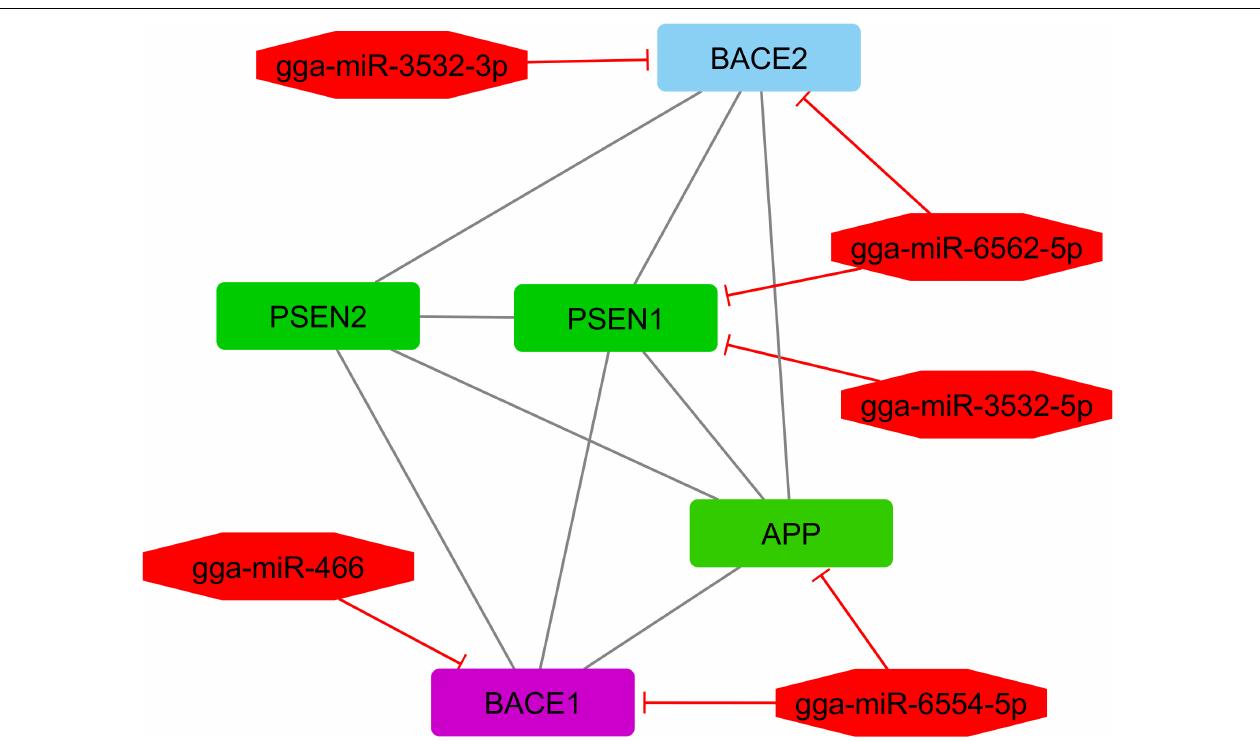
FIGURE 5 | Module 2: five genes and five miRNAs in the interactive bipartite network of gene–miRNA. In this network, the quadrilateral points represent genes; and the octagonal points represent miRNAs. In this interactive bipartite network of gene–miRNA, quadrilateral nodes represent genes; and octagonal nodes represent the miRNAs. For miRNAs and target genes, the edges indicate the suppressing roles of miRNAs. The edges of genes also indicate the gene–gene interactions. The green quadrilateral nodes represent the genes with the highest gene–gene interactions with other genes in the network (or hub genes). Purple quadrilateral nodes indicate the genes with the highest suppression by miRNAs.